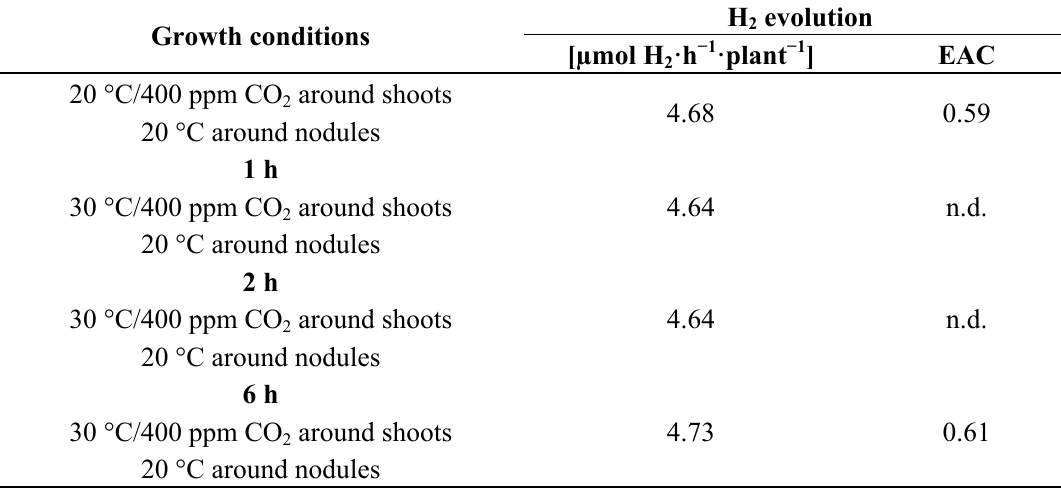
Table 1. H evolution of M . truncatula nodules after short-term increase of the temperature 2 around shoots. Data are given as means of 10 replicates. The electron allocation coefficient (EAC, relative efficiency of nitrogenase) was measured at the beginning and the end of the experiment Data were compared statistically (within a column) between the points in time of the analysis but showed no significant differences ( Tukey ’s test, p < 0.05, n = 10; comparison of the EAC by the t -test, p < 0.05, n =